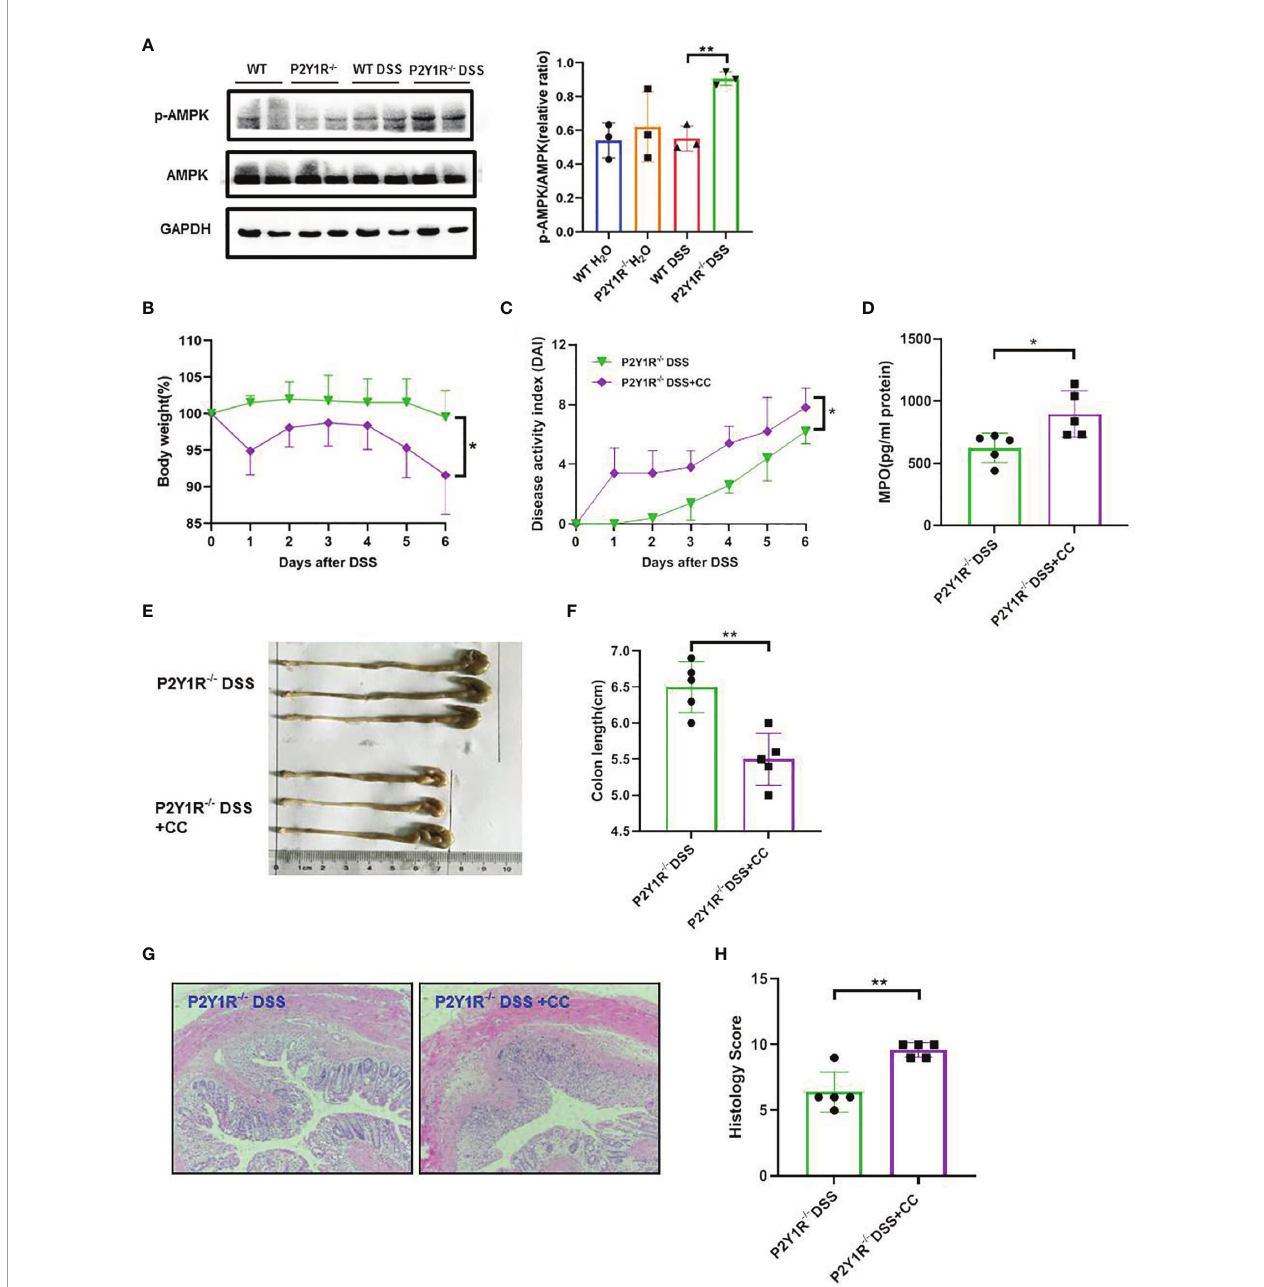
FIGURE 5 | Blockage of AMPK worsens the severity of colitis in DSS-treated P2Y1R -/- mice. (A) P2Y1R de fi ciency induces AMPK phosphorylation in the colon of DSS-treated mice (n=3). (B) Body weight change. (C) Disease activity index (DAI). (D) Myeloperoxidase (MPO) level. (E) Representative photographs of colon. (F) Colon length. (G) Representative photographs of H&E staining (magni fi cation × 200). (H) Histopathological score of colon tissues. Data are expressed as mean ± SEM (n=5). *p < 0.05 and **p <